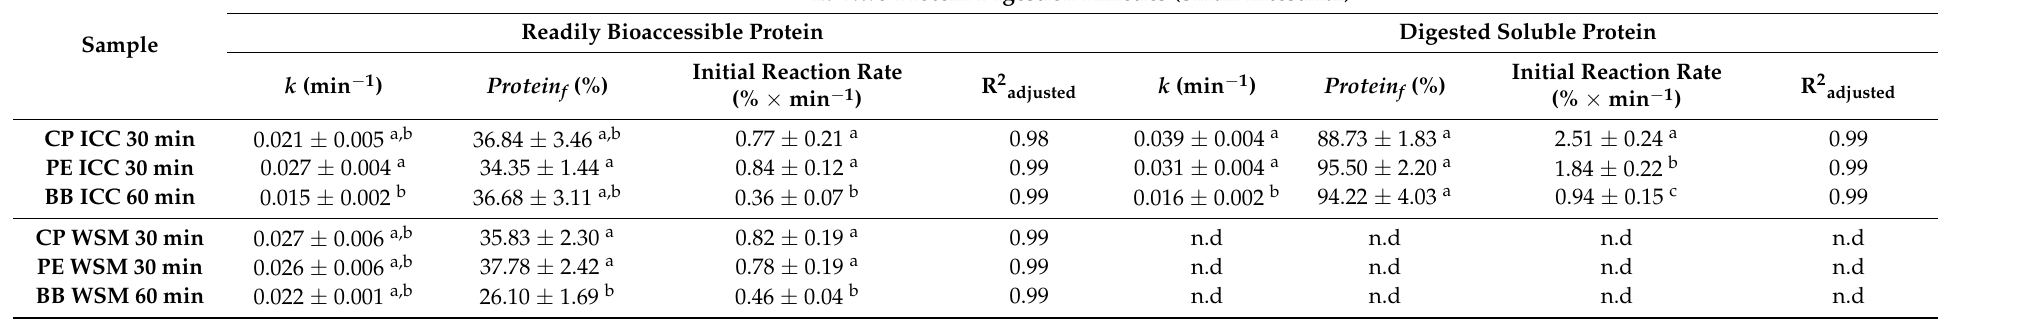
Table 3. Estimated kinetic parameters ± standard deviation of in vitro protein digestion of individual cotyledon cells (ICC) and whole pulse seeds (WSM) from chickpea (CP), pea (PE), or black bean (BB) aligned to equivalent hardness levels using hydrothermal treatment for 30, 30, or 60 min, respectively. Protein digestion kinetic parameters were estimated by fitting the experimental data to a fractional conversion model (Equation (4)). Mean values (within a column) with different superscript letters are significantly different based on 95% confidence